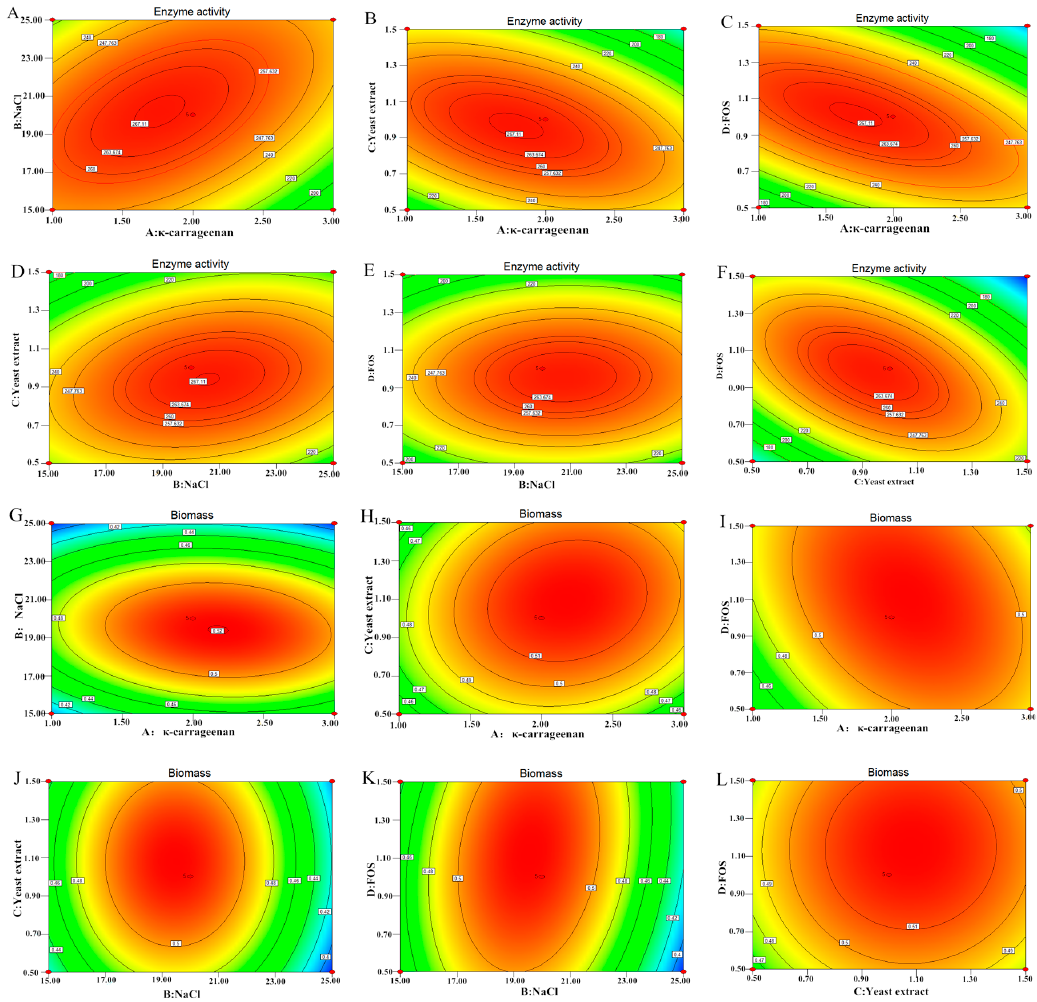
Figure 5. ( A – F ) was the interaction effect of variables on enzyme activity (EA); ( G – L ) was the interaction effect of variables on biomass (BM).